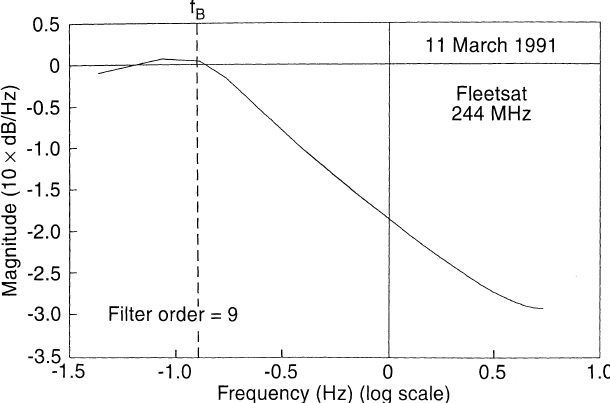
Fig. 2. The power spectrum of stage 1 scintillation. The break frequency, f B , is clearly marked and corresponds to the theoretically calculated Fresnel frequency of 0.171